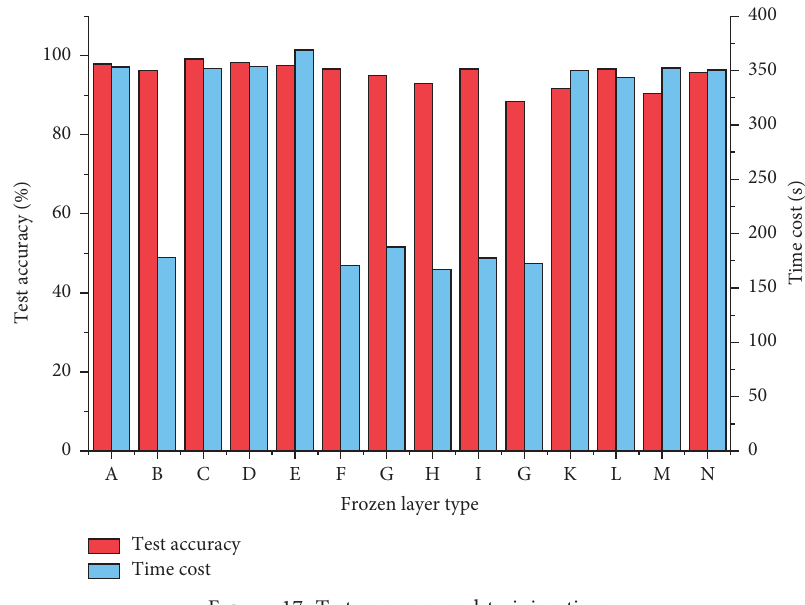
Figure 17: Test accuracy and training time.